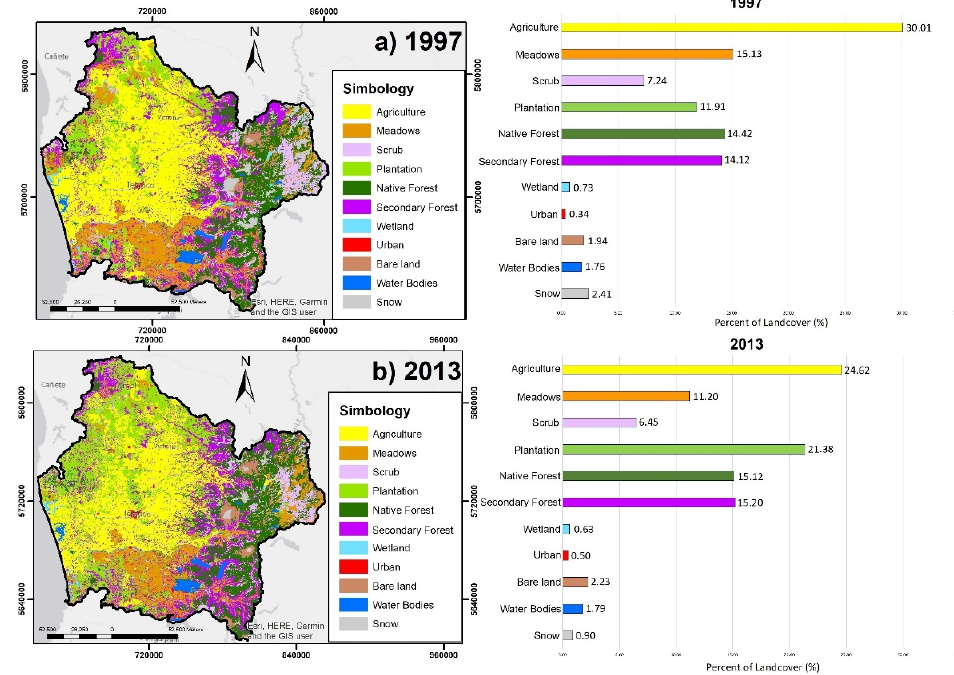
Figure 3. Changes in use/coverage at the regional level in 1997 and 2013.